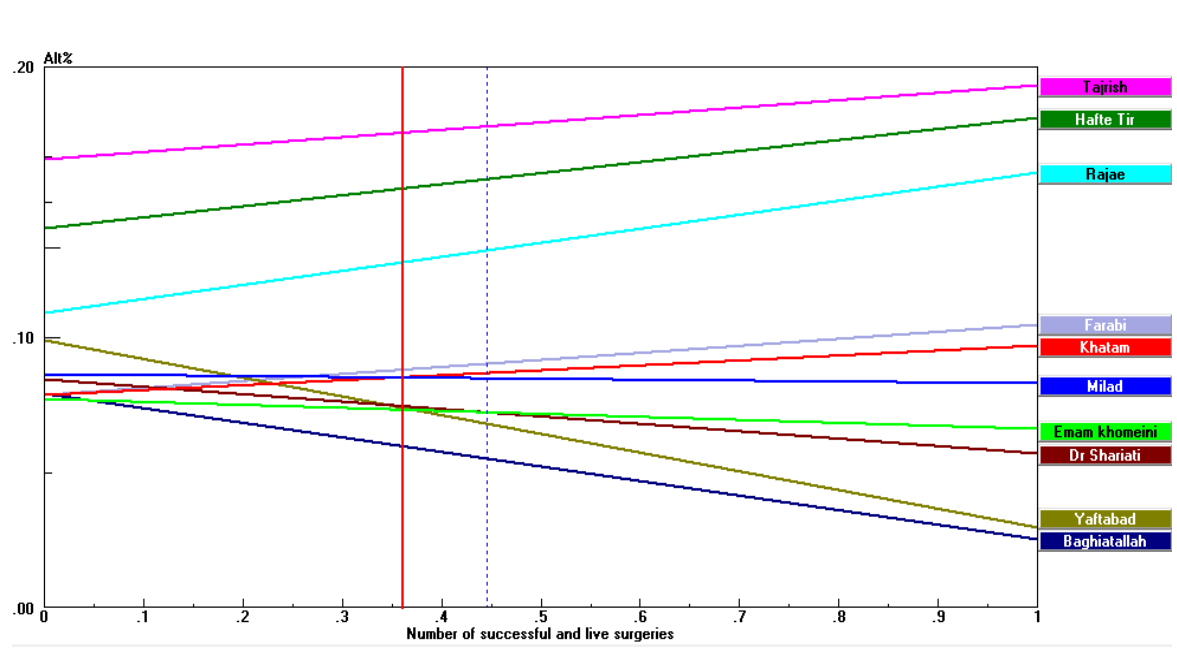
Figure 15. Gradient sensitivity with respect to ‘Number of successful and live